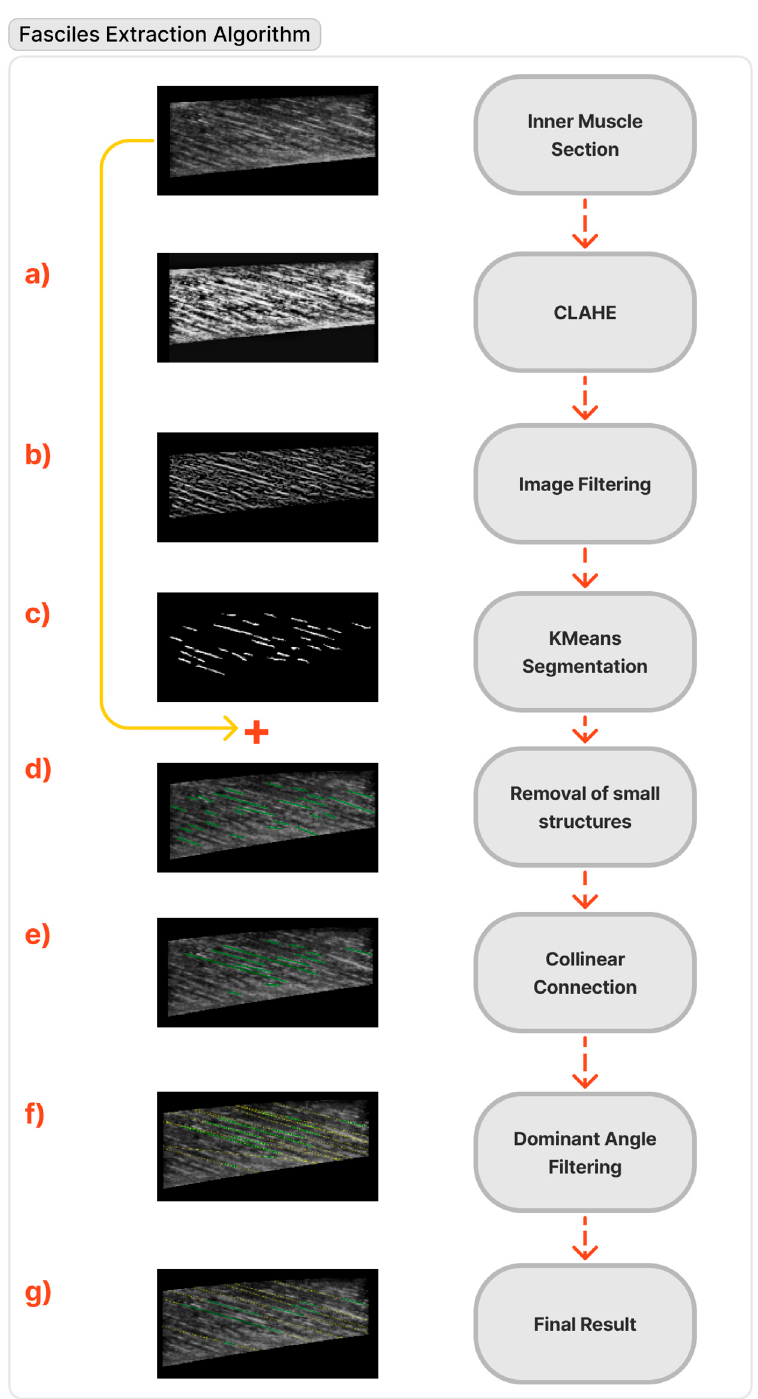
Figure 5. Flow chart of the muscle fascicles extraction pipeline.